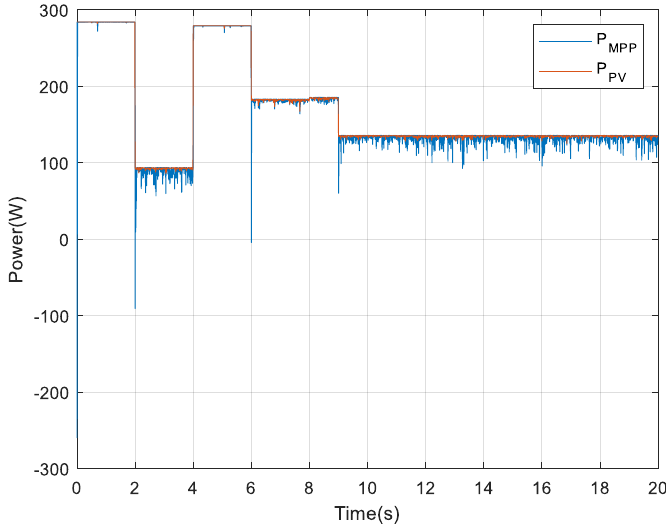
Figure 25. Temporal evolution of the PV generator power.